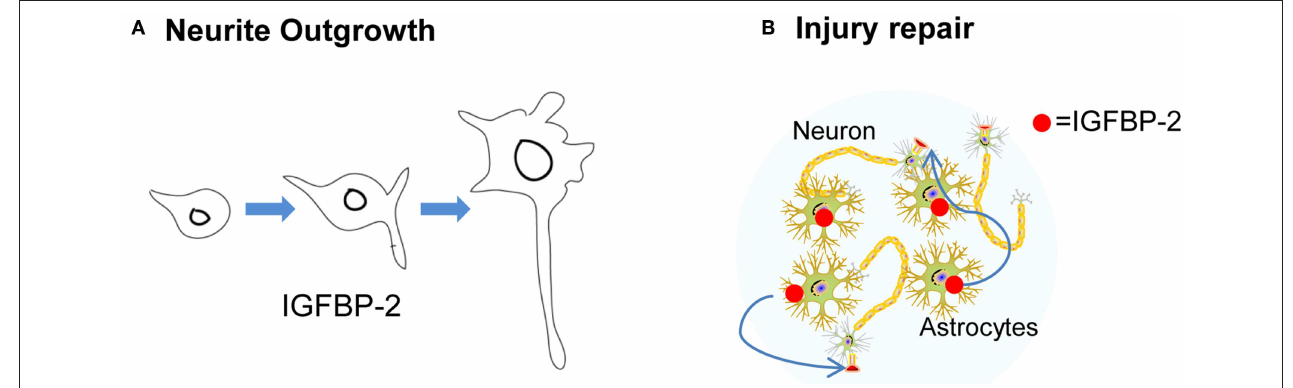
FIGURE 3 | The neurotropic function of IGFBP-2. (A) IGFBP-2 is involved in neurite outgrowth. (B) IGFBP-2 plays a crucial role in CNS injury and